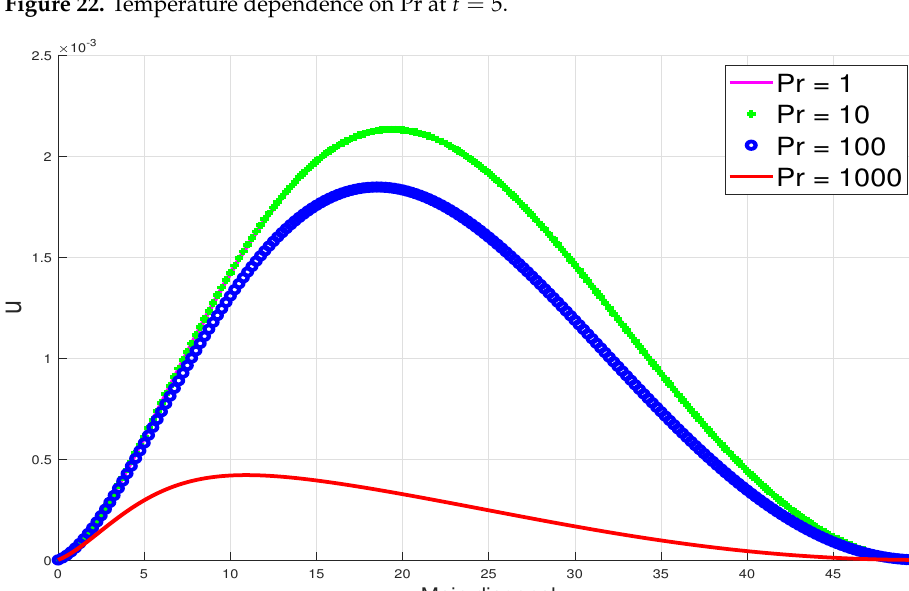
Figure 22. Temperature dependence on Pr at t = 5.